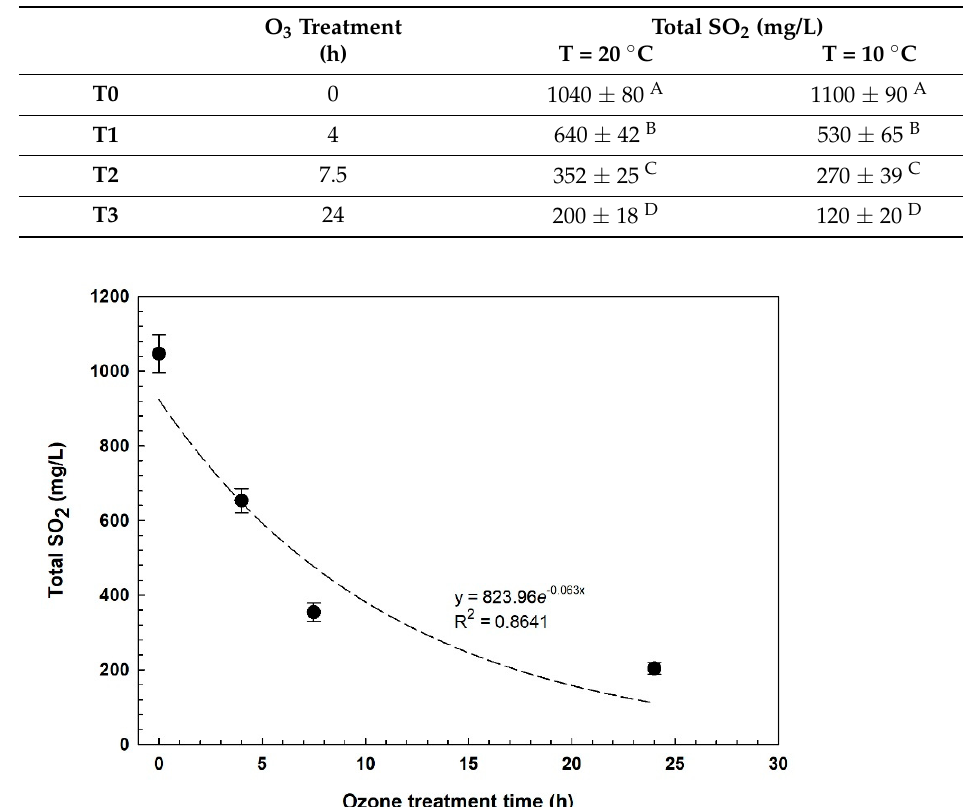
Figure 1. Regression curve of total SO 2 at 20 °C in the red sulfited must over the ozone treatment